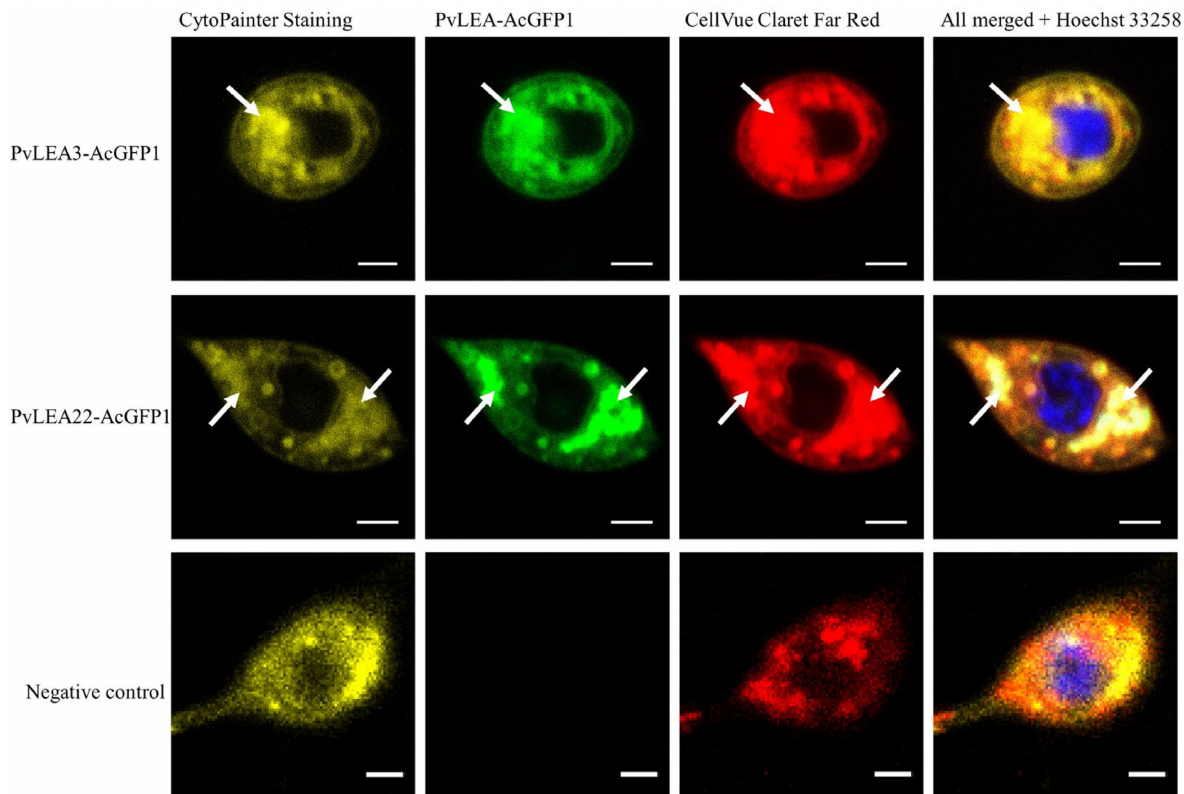
Figure 4. Endoplasmic reticulum (ER)/Golgi staining of Pv11 cells in control and after expression of PvLEA3–AcGFP1 and PvLEA22–AcGFP1 chimeras. ER and Golgi apparatus in Pv11 cells were stained with a CytoPainter Staining Kit (Abcam, Waltham, MA, USA) and DNA was stained with Hoechst 33,258 (Sigma, Saint Louis, MO, USA). The scale bar is 2 µ m. The following filters were used: excitation at 405 nm, emission at 410–508 nm (blue channel); excitation at 488 nm, emission at 490–633 nm (green channel); excitation at 633 nm, emission at 638–759 nm (red